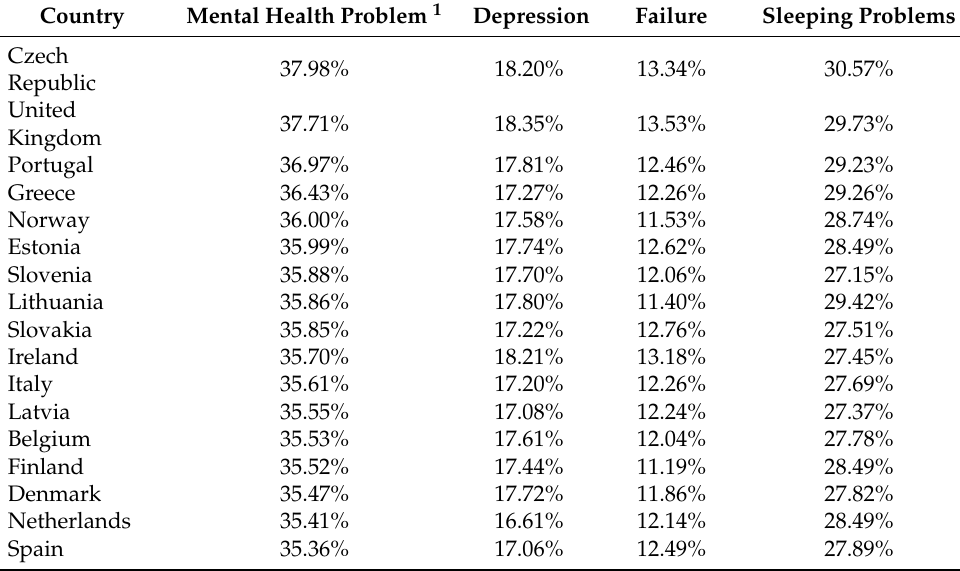
Table 3. Mental health disorders frequency in EU+